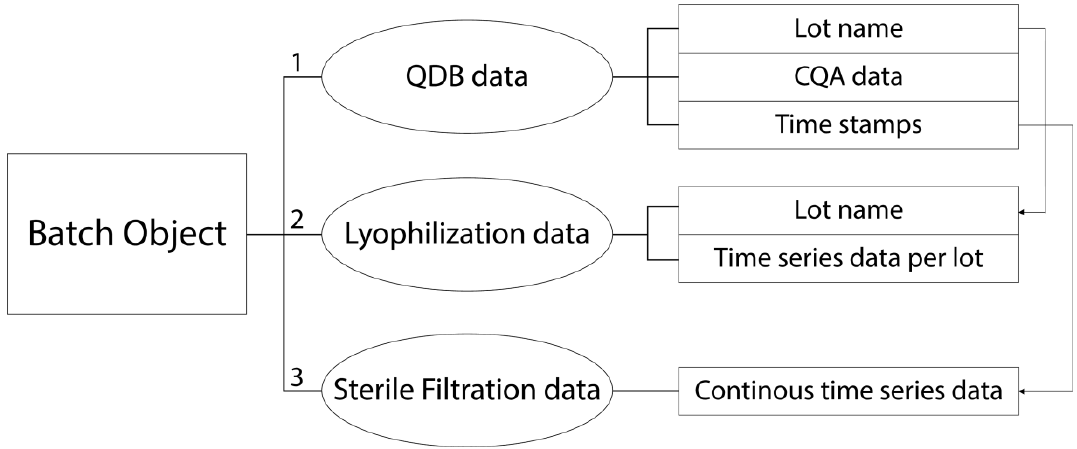
Figure 2. Scheme of the data alignment, showing the workflow and the individual contents of the data sources. All available data are stored in a batch object within the inCyght data base (IDB). The data alignment from various data sources to one batch object can.